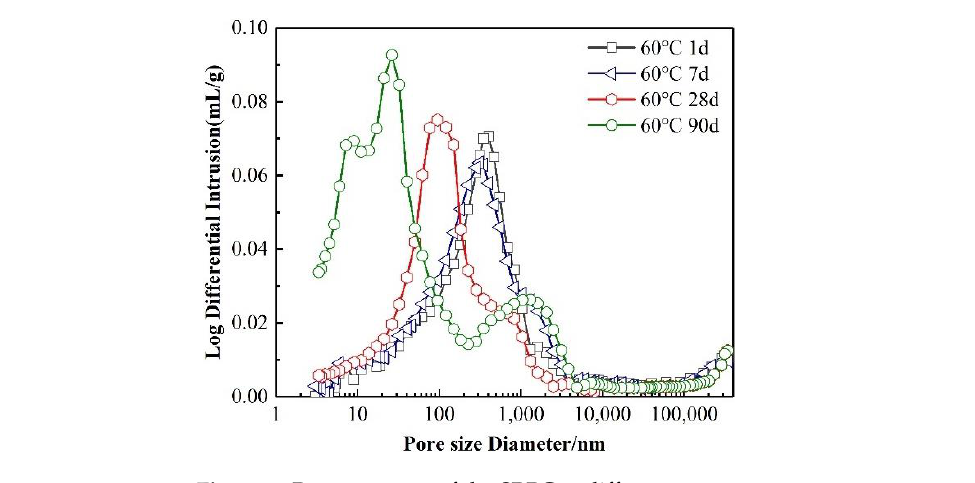
− 23.3 Table 4. Reliability analysis of compressive strength test results. Text/Mixture